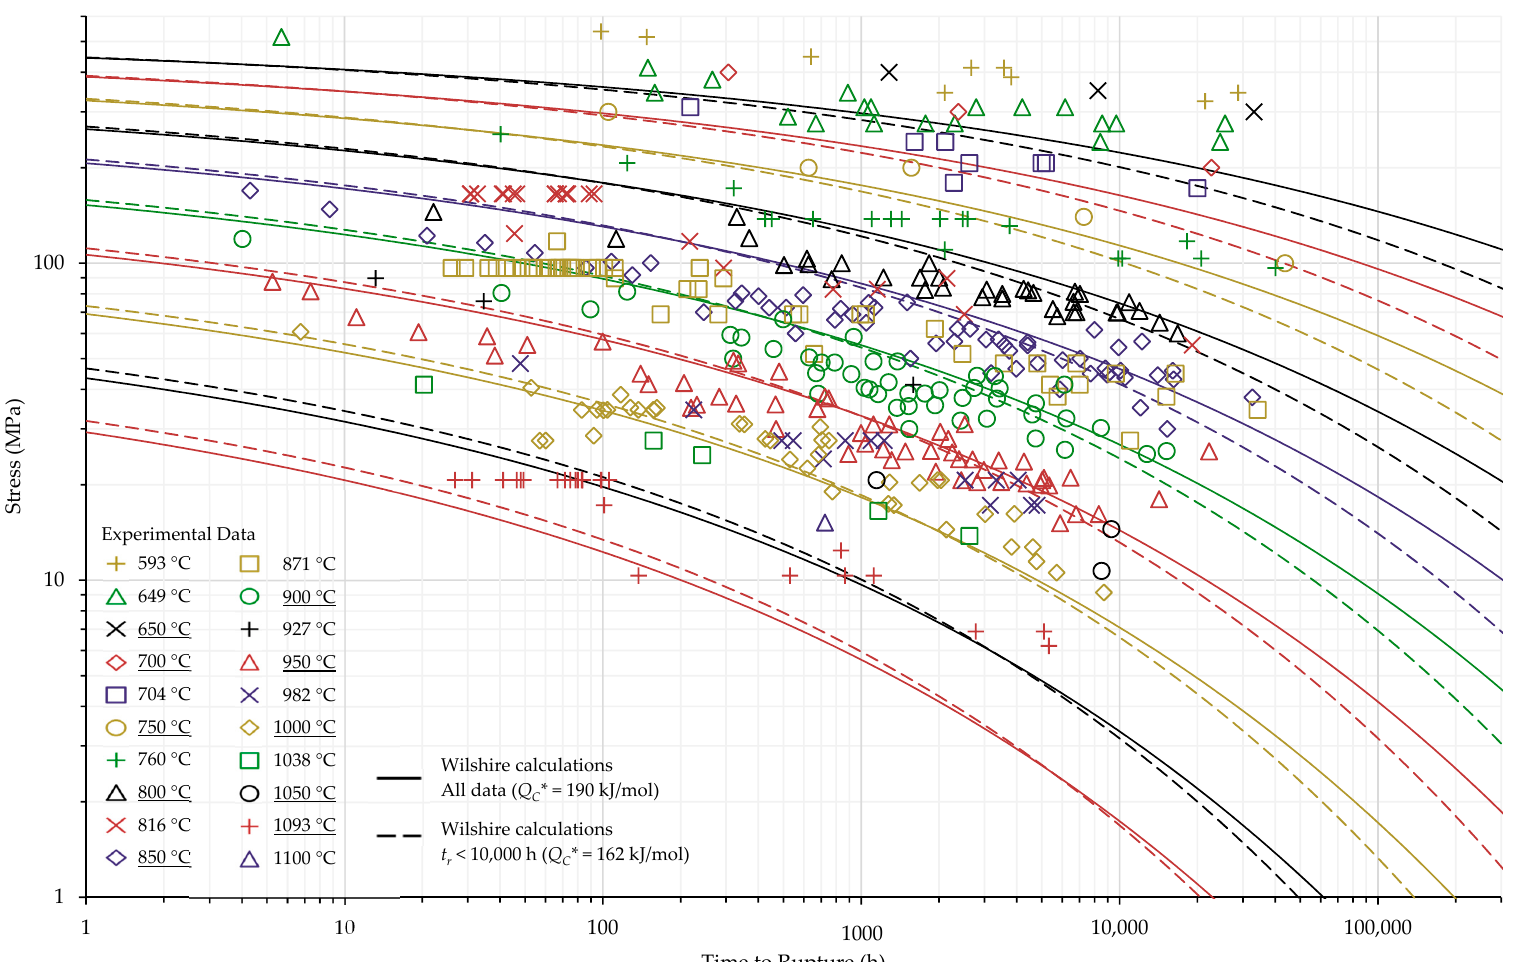
Figure A6. Single region calculations of the Wilshire equation with Q ∗ determined using Arrhenius plots for Inconel 617 shown at underlined temperatures.